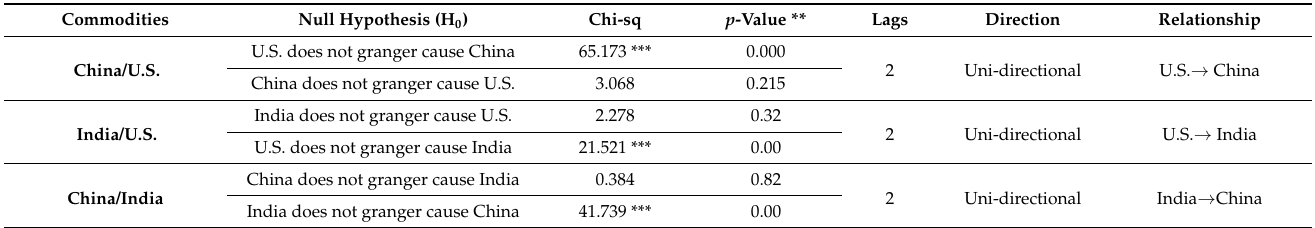
Table 9. Estimates of Toda–Yamamoto Granger Causality Test (Second